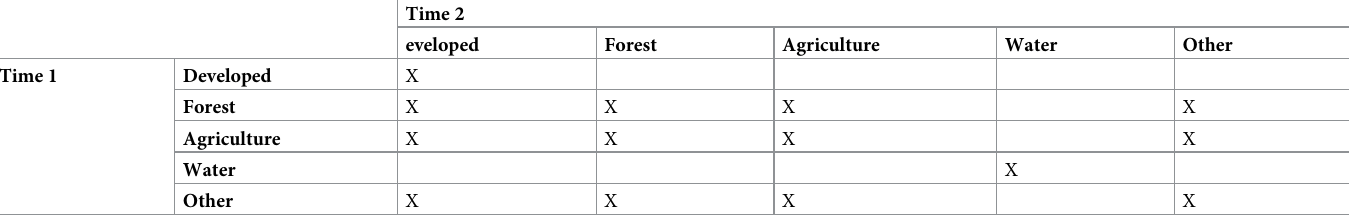
Table 1. Transitions between land uses in this study. Only those marked with an X were considered when generating the transition probability model or the spatial